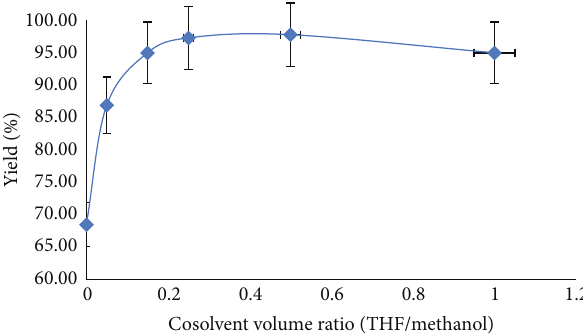
Figure 5: Effect of cosolvent volumetric ratio (THF/methanol) on percentage biodiesel